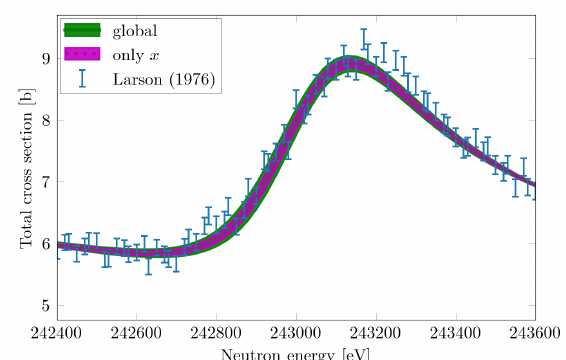
Figure 11. Uncertainty band obtained with the global criteria compared to the one obtained after the Bayesian